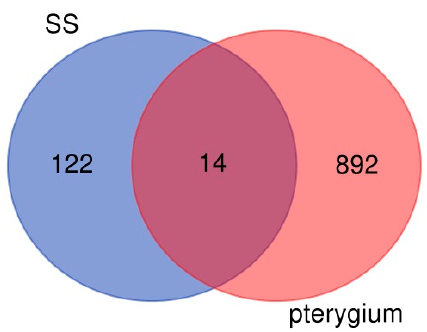
Figure 3. Venn diagram of the up-regulated differentially expressed genes (DEGs) in primary Sjögren Syndrome (pSS) and pterygium samples. Left circle represents pSS, while right circle represents pterygium samples. 14 genes ( IRAK1 , LEF1 , CTSS , HLADPA1 , S100A8 , ARHGDIB , CD59 , TAP2 , ICAM1 , IL4R , CEACAM1 , BAX , IL1R1 , S100A9 ) that are up-regulated in both pterygium and pSS samples were screened out. The online diagram tool [http://bioinformatics.psb.ugent.be/webtools/ Venn/ (accessed on 20 March 2022)] was used to construct a Venn diagram.